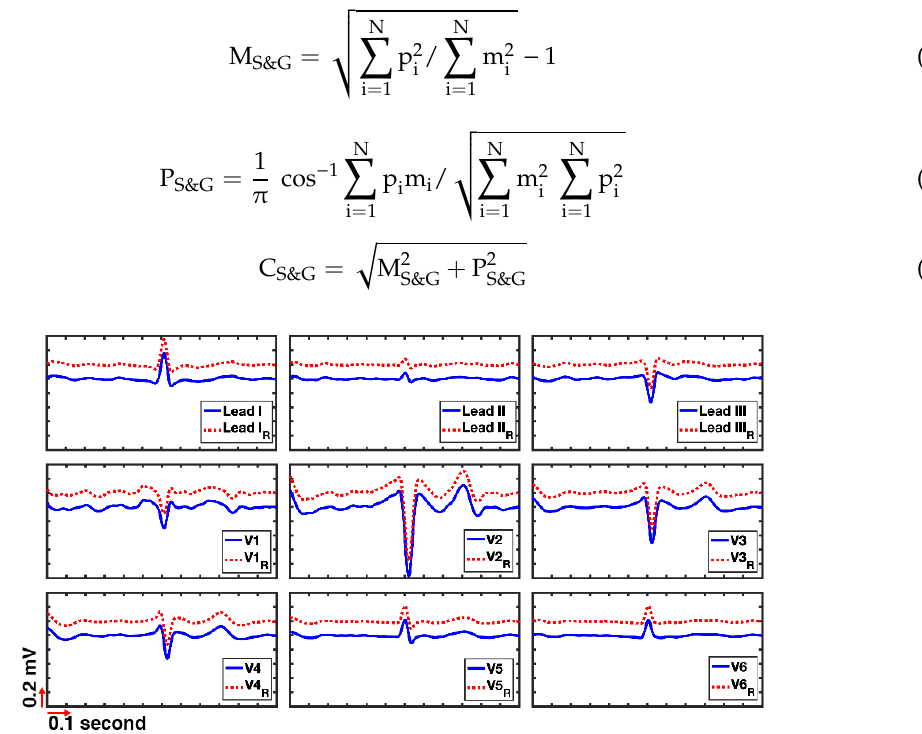
Figure 2. Comparison between recorded and reconstructed leads, shown with subscribed ‘R’.